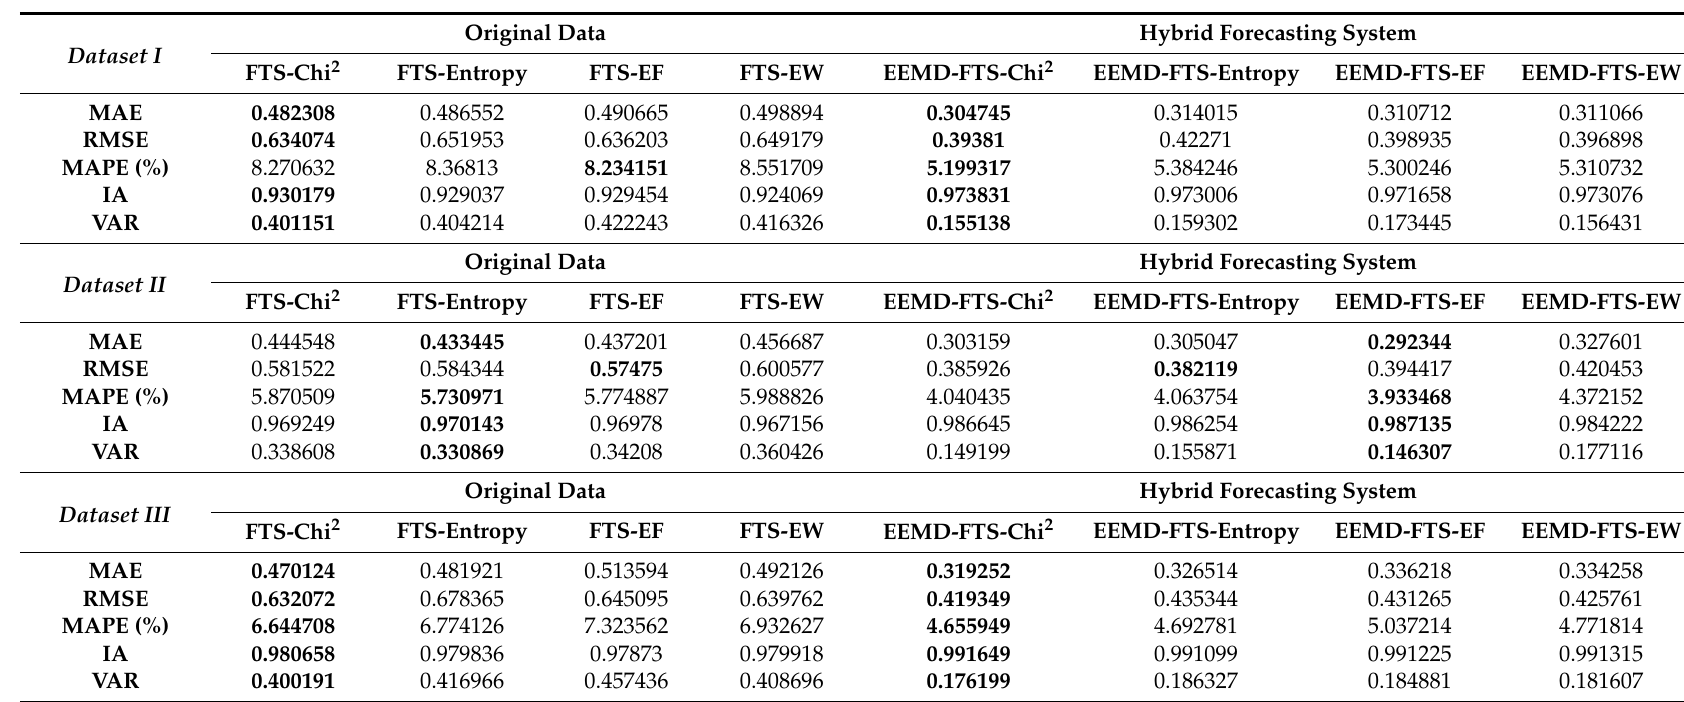
Table 10. Comparison of fuzzy time series using different interval partitioning